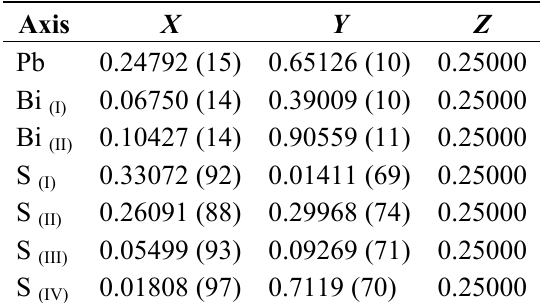
S )(PbS) thin films, ( A ) As-deposited; ( B ) Annealed at 623 K for 2 3